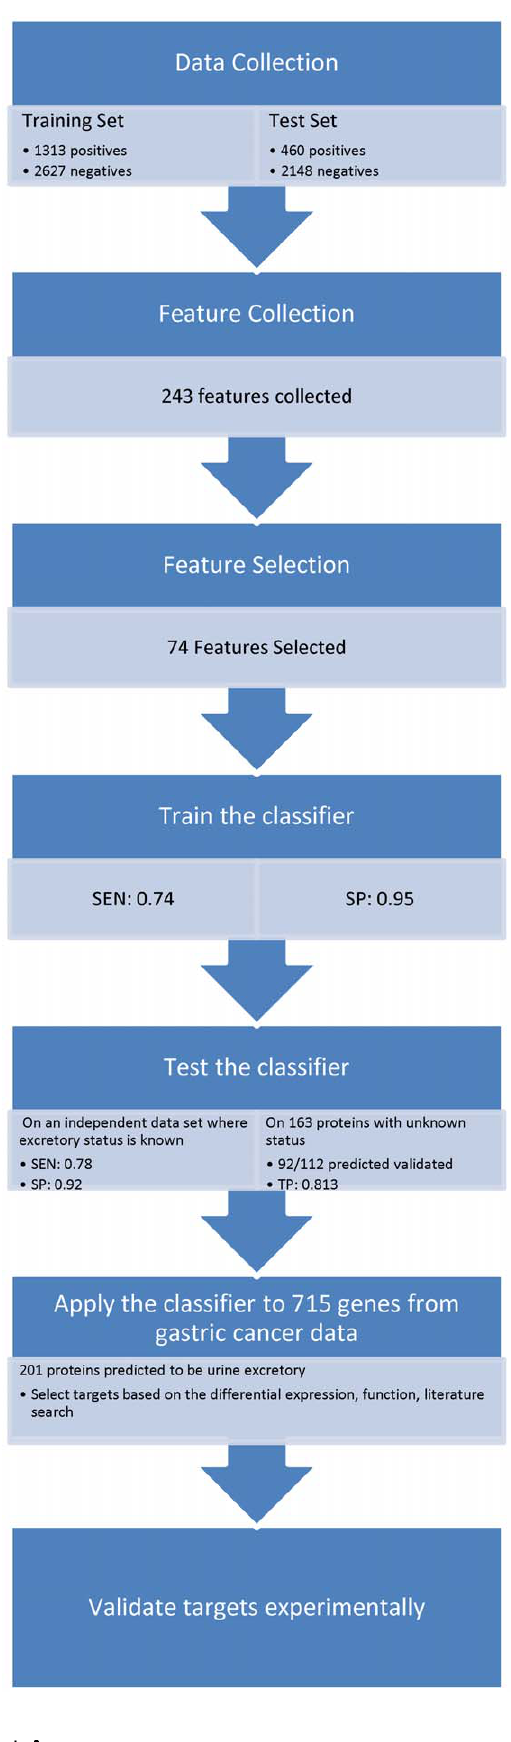
Figure 1. The flow of the